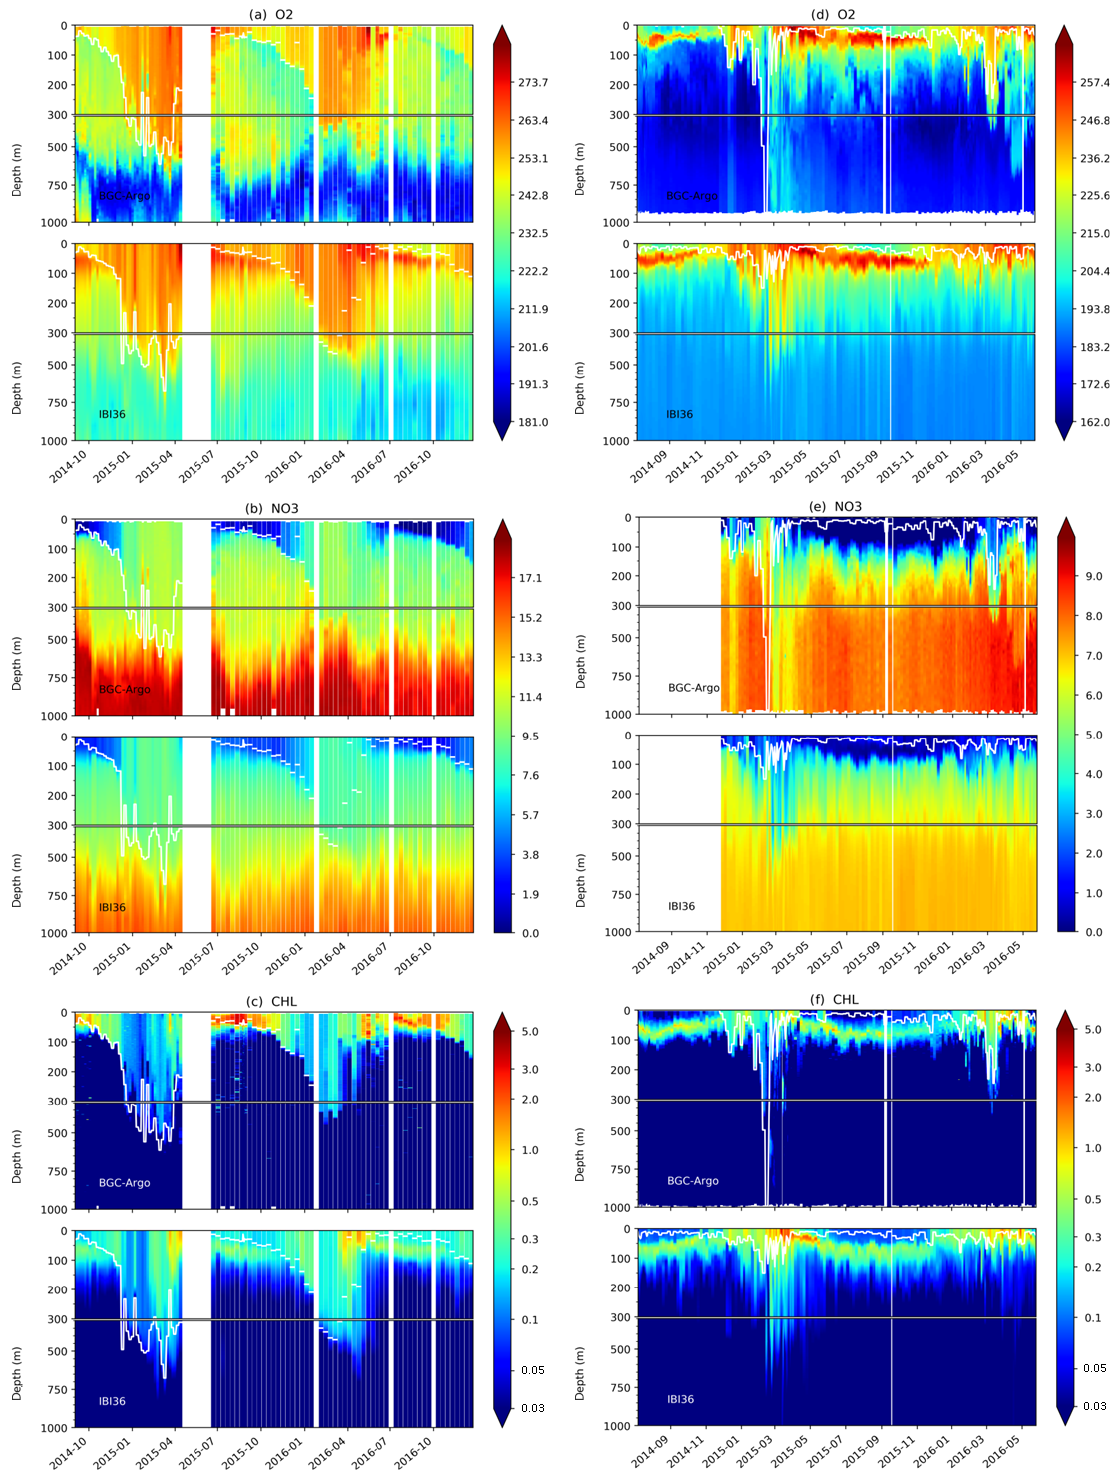
Figure 16. Time series of oxygen (top), nitrate (middle) and Chl a (bottom) from BGC-Argo data and IBI36 for the Atlantic (left) and Mediterranean (right). Oxygen and nitrate are expressed in µmolL − 1 and Chl a in mgChlm − 3 . IBI36 and Argo data are collocated in space and time. The white line represents the MLD computed from density criterion of 0.03kgm − 3 difference from